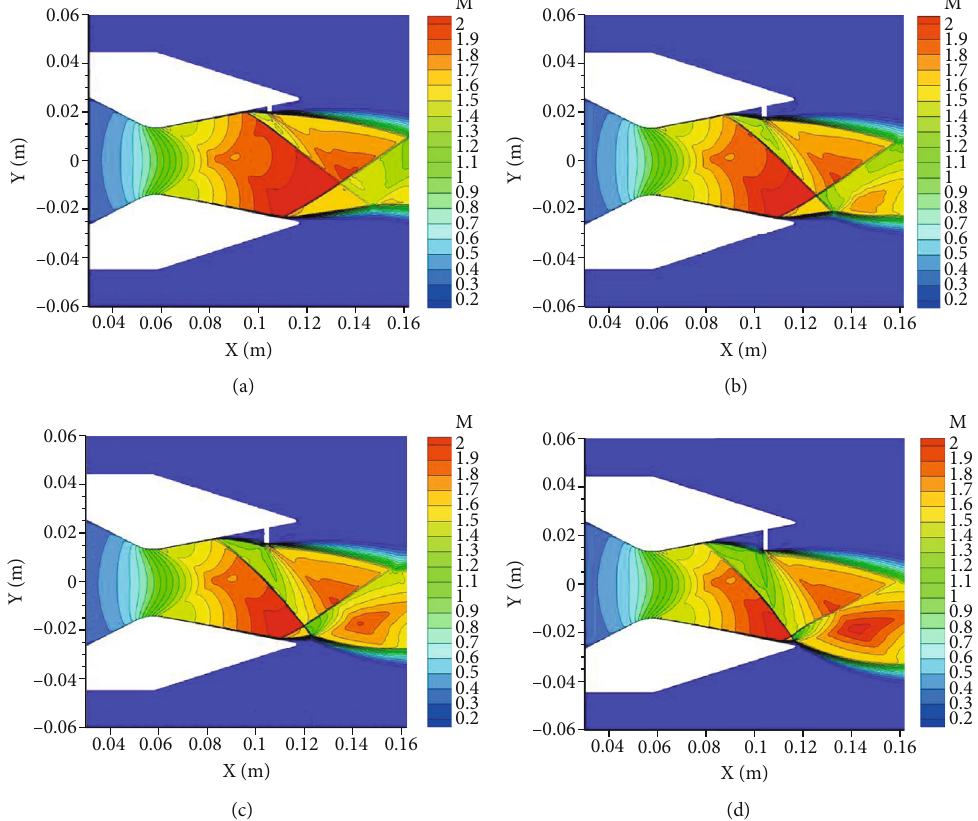
Figure 9: Mach contours for diverse rod penetration heights ( NPR = 4 : 6 and X = 0 : 58 (d) H / R t